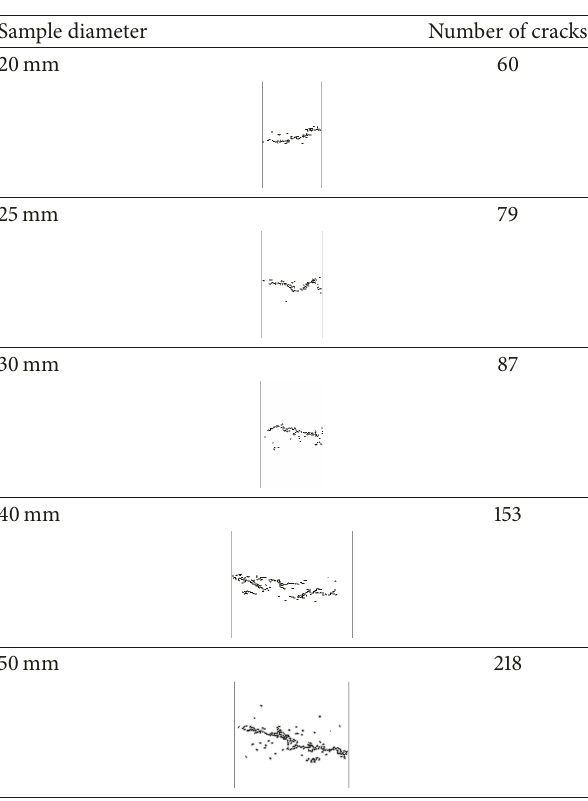
Table 7: Crack propagation characteristics of disk samples with different